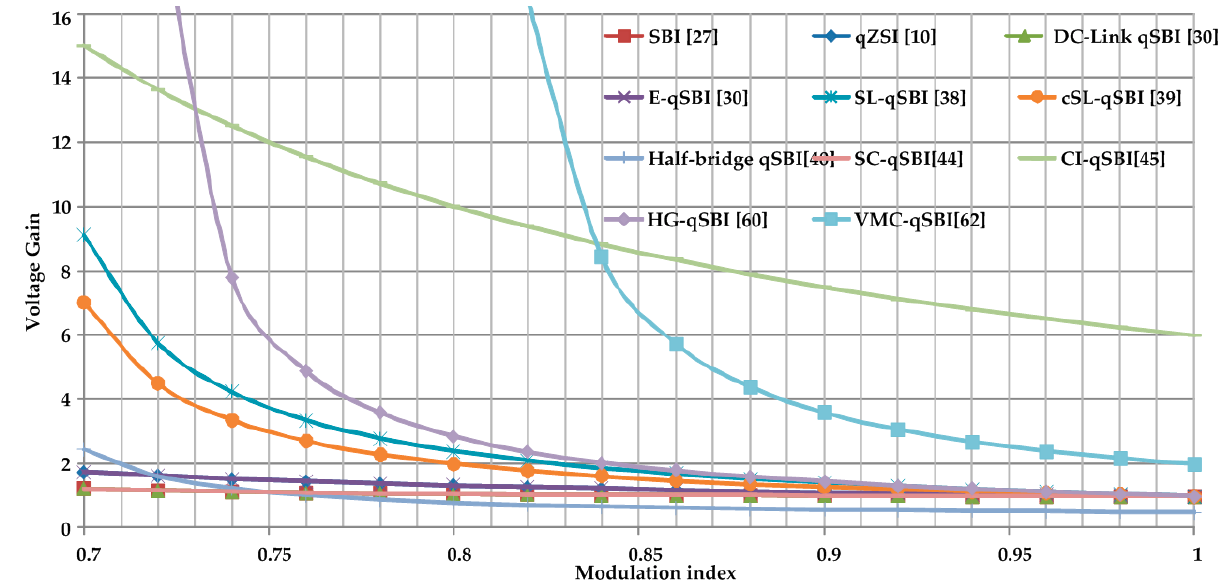
Figure 22. Voltage gain as a function of the modulation index for the topologies enlisted in Table 1.